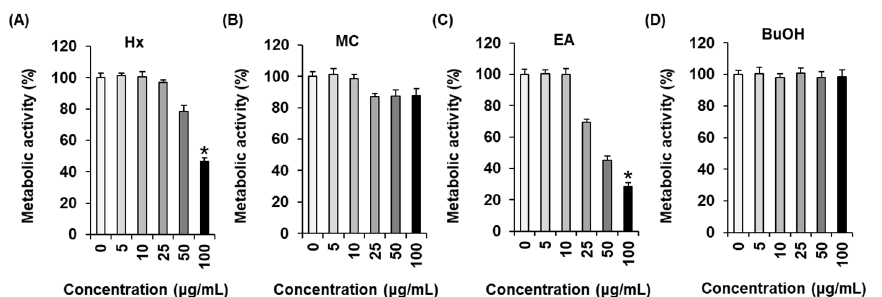
Figure 1. E ff ects of L. cuneata methanolic extract fractions on metabolic activity in MCF-7 human breast cancer cells. The n -hexane (HX) ( A ); dichloromethane (MC) ( B ); ethyl acetate (EA) ( C ); and n -butanol (BuOH) ( D ) fractions exerted inhibitory e ff ect on metabolic activity in MCF-7 cells. Control cells were treated with 0.5% DMSO. The experiment was performed in triplicate, and the error bars represent the standard deviation of samples ( n = 3). * p < 0.05 compared with the control.